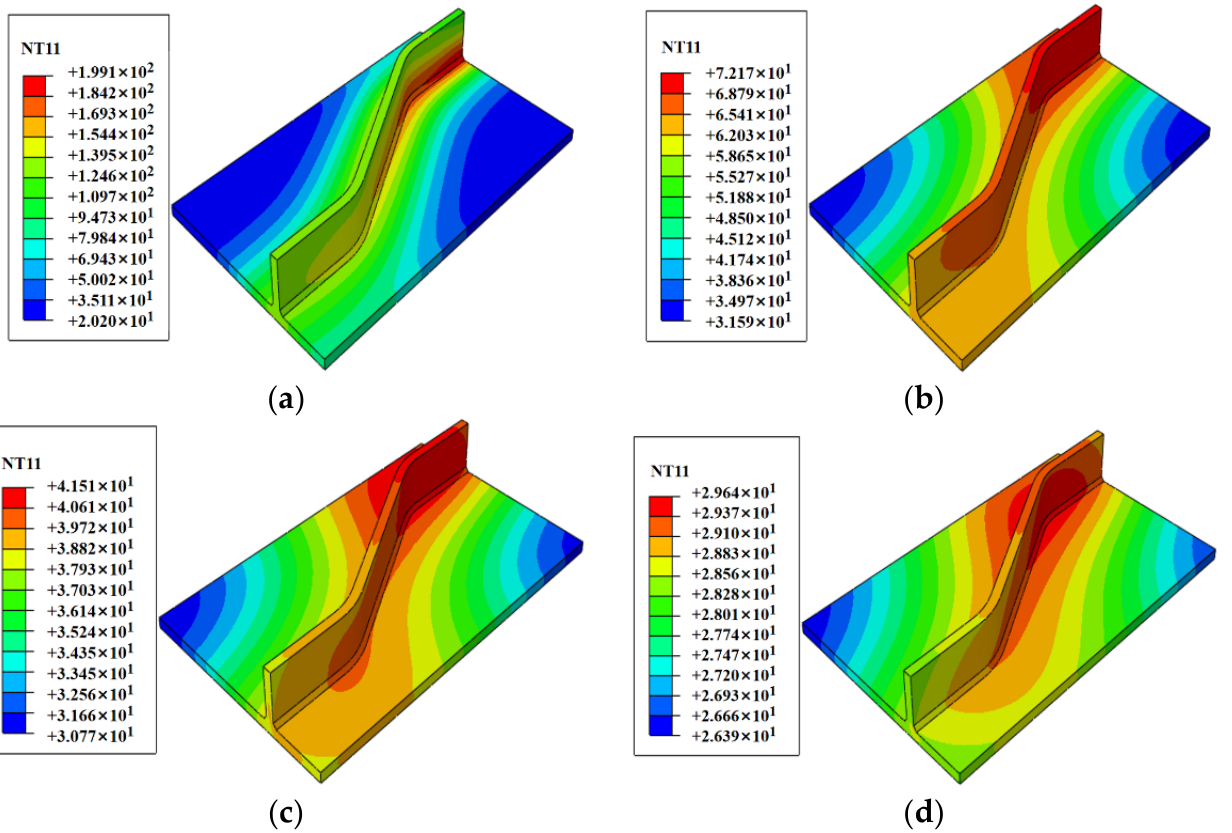
Figure 11. Time course of temperature field cloud image in the cooling stage (unit: °C); ( a ) Temperature field at 100 s; ( b ) Temperature field at 1000 s; ( c ) Temperature field at 2000 s; ( d ) Temperature field at 3000 s.